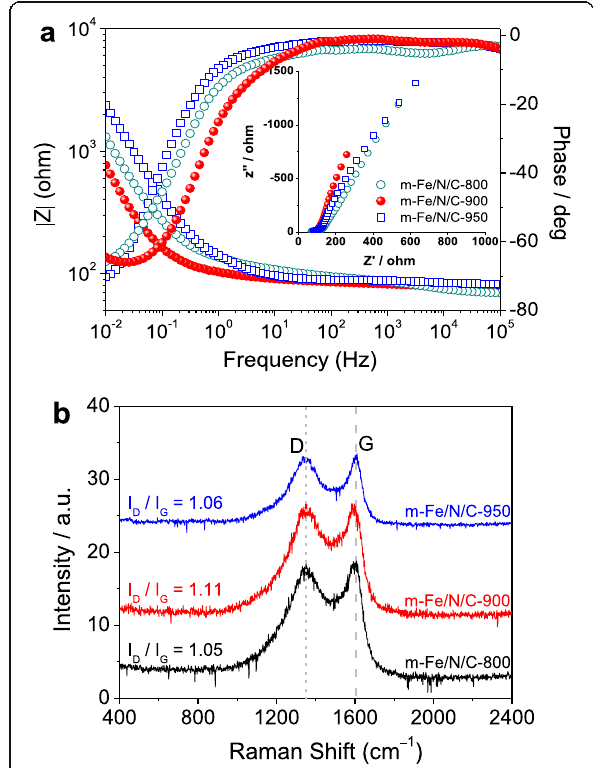
Fig. 3 a EIS bode plot of m-Fe/N/C-800, m-Fe/N/C-900, and m-Fe/N/ C-950; the inset is the corresponding Nyquist plot. b Raman spectra of m-Fe/N/C-800, m-Fe/N/C-900, and